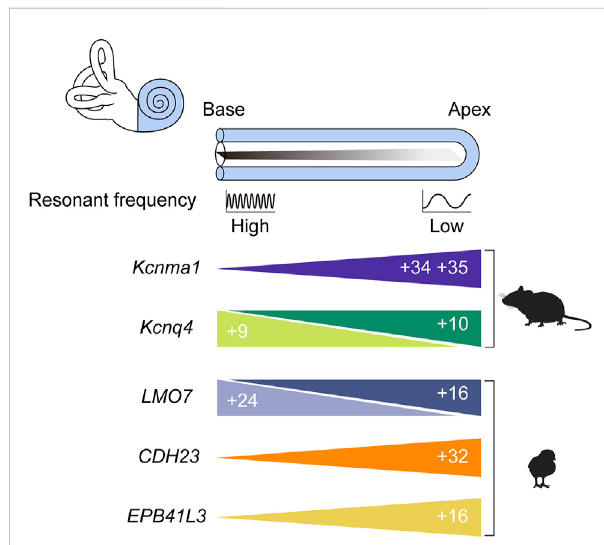
FIGURE 5 Tonotopic AS events. The cochlea is depicted unwound such that its longitudinal axis is straightened. The region of thestraightened cochlear duct farthest from themiddle ear iscalled the apex ,the most proximal region is the base , and the virtual line joining these regions is the longitudinal or tonotopic axis . The colored triangles represent the relative abundance of splice variants for the indicated gene along the axis. The numbers inside the triangles refer to the exons that characterize each variant, and the cartoons next to the triangles indicate the organism in which the tonotopic expression of each splice variant has been veri fi